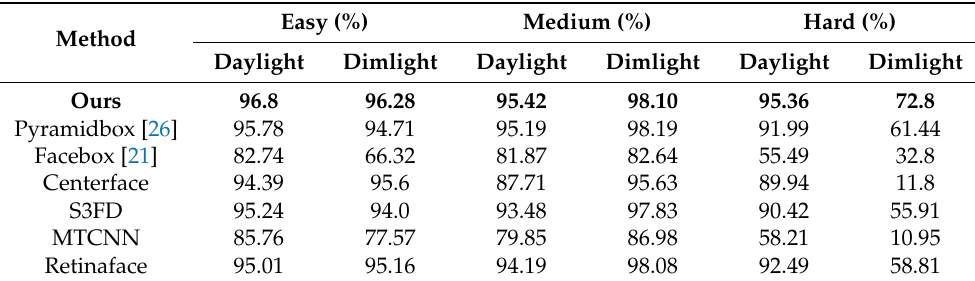
Table 5. Comparison with open-source